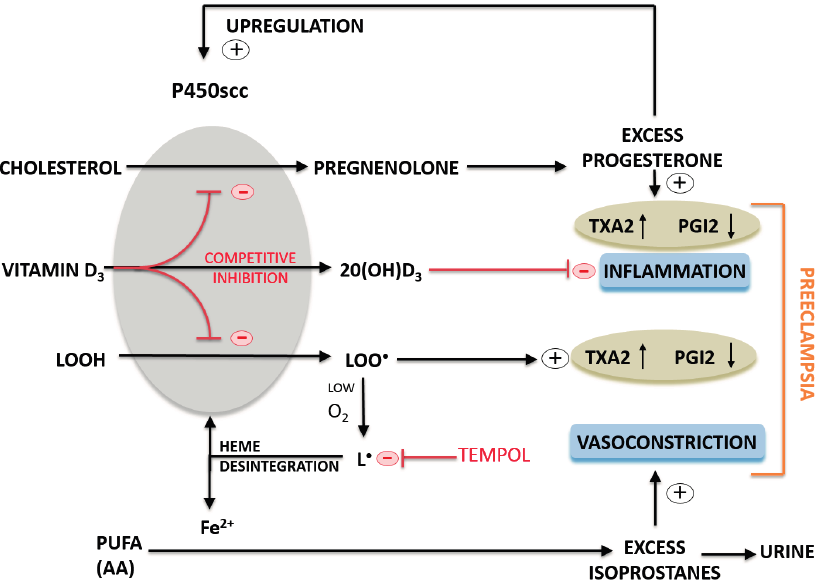
Figure 6. A proposed molecular mechanism of high-dose Vitamin D 3 supplementation in prevention or treatment of preeclampsia. Vitamin D 3 acts as a competitive inhibitor of placental cytochrome P450scc preventing the production of lipid peroxides and excess progesterone, both of which may contribute to the etiopathogenesis of preeclampsia. 4-OH-TEMPO (TEMPOL) protects placental mitochondria as an effective scavenger of carbon-centered